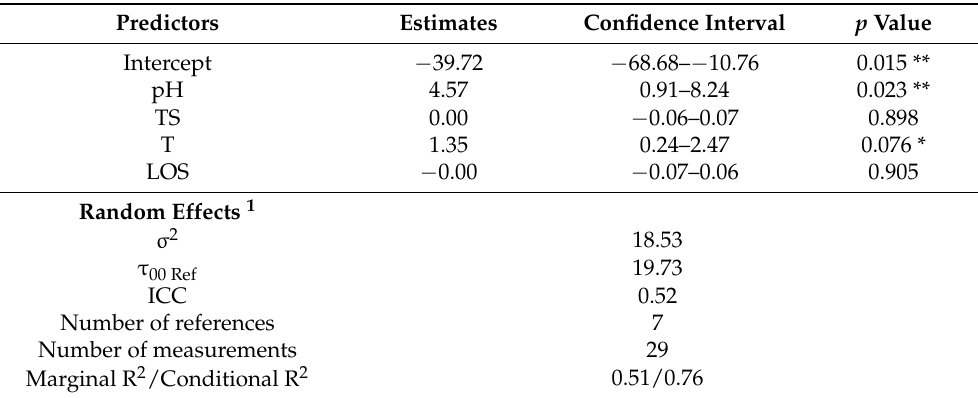
Table 4. Parameter estimates of linear mixed effects model for NH 3 –N emissions from slurry storage